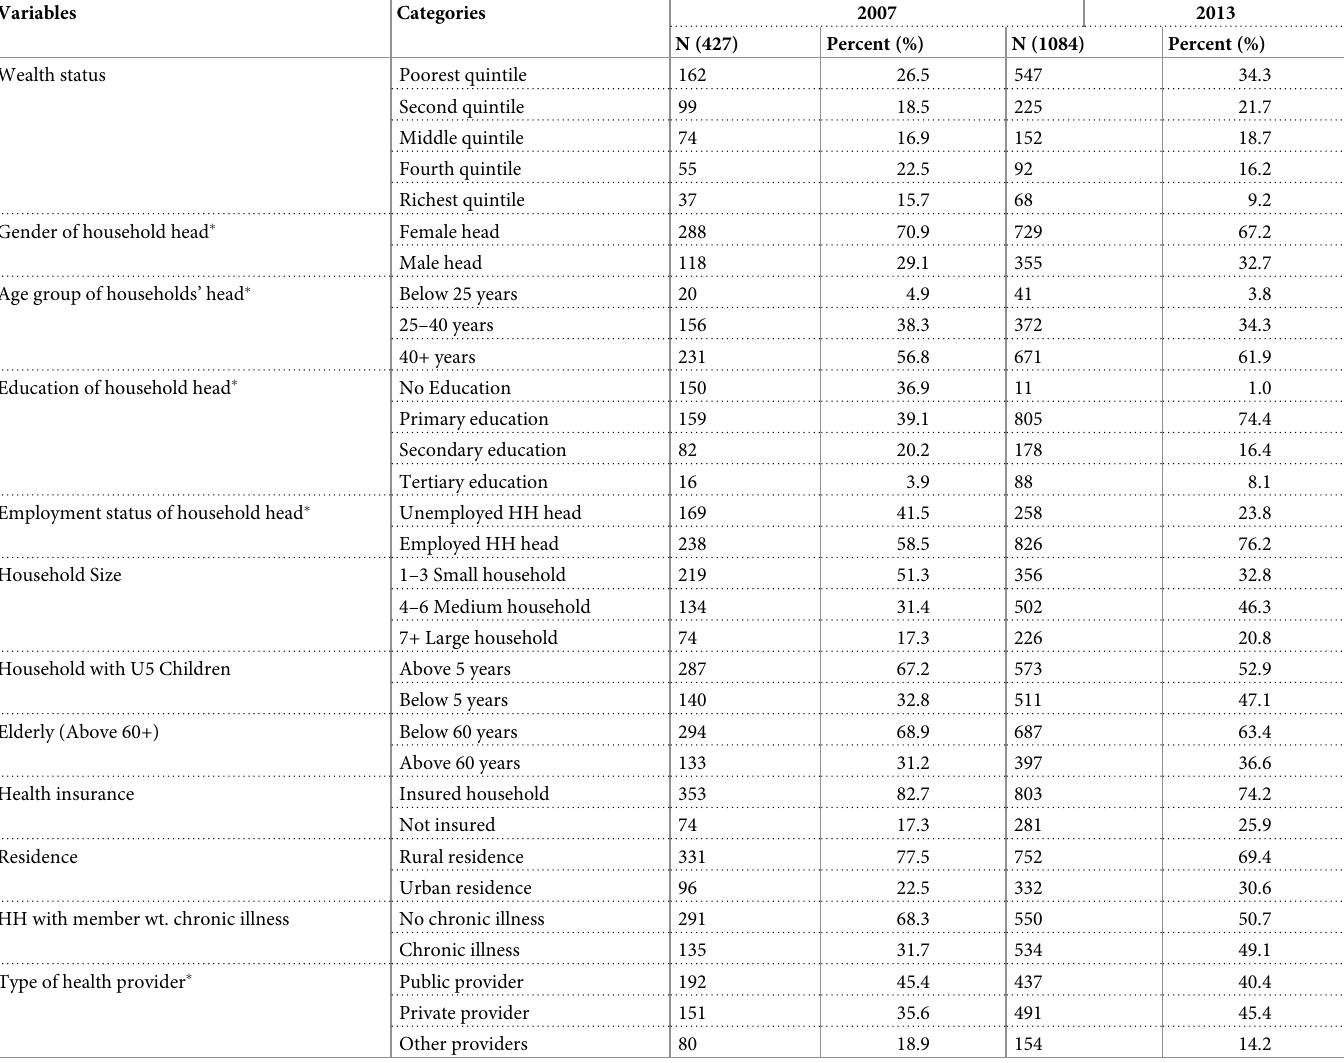
Table 1. Socioeconomic characteristics of the households that experienced catastrophic health